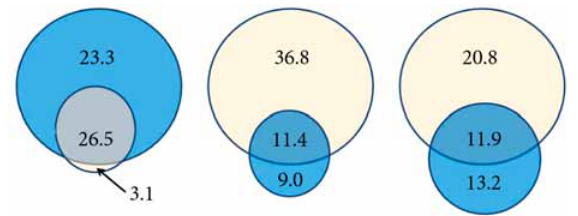
Fig. 2. Partitioning of the variances in carbon stock into percentages explained by regional properties (blue cycle), local factors (orange cycle), and their covariance (intersection). Numbers in the respective circles outside the intersection represent the variance explained by pure regional properties and pure local